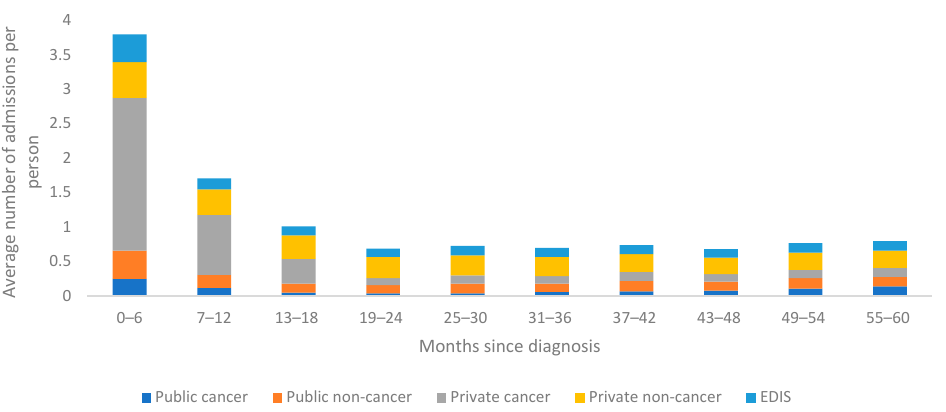
Figure 2. Average number of admissions per person over five years for females diagnosed with breast cancer in Queensland, Australia between 1 July 2011 and 31 June 2013. The total MBS and PBS costs within this study were $35.4 million and $9.9 million, respectively. There was a total of 1,697,459 MBS items claimed by breast cancer patients over five years, an average of 315 (SD = 187) claims per person. There was a total of 972,649 PBS pharmaceuticals claimed by breast cancer patients over five years, an average of 181 (SD = 145) claims per person. The highest average and total cost and number of items accessed for both MBS and PBS were highest during the first six months post-diagnosis (see Figures 1 and 3). For the remaining time, MBS and PBS items claimed and average costs remained relatively similar. On average, individuals within this sample paid $1836